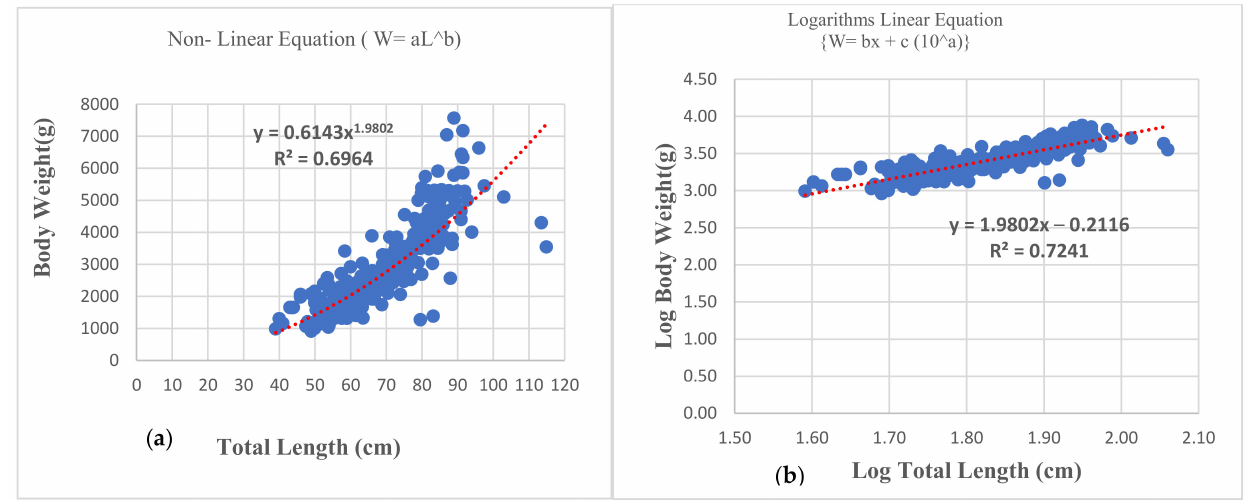
Figure 2. Total length-weight relationships of rescued Chinese pangolins (where a = Intercept and b = Slope of equation).